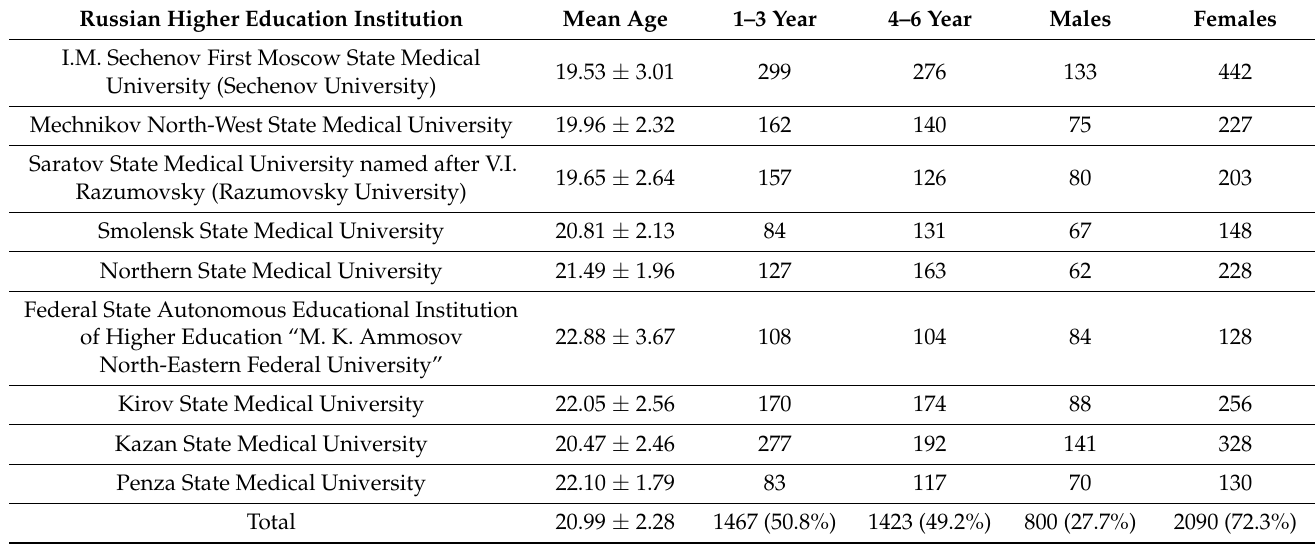
Table 2. Mean age of surveyed medical students and their number according to sex and